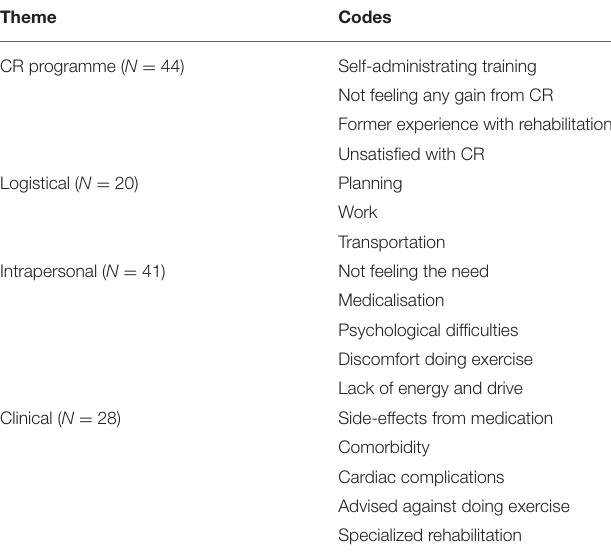
TABLE 1 | Themes and codes from the audit. Theme